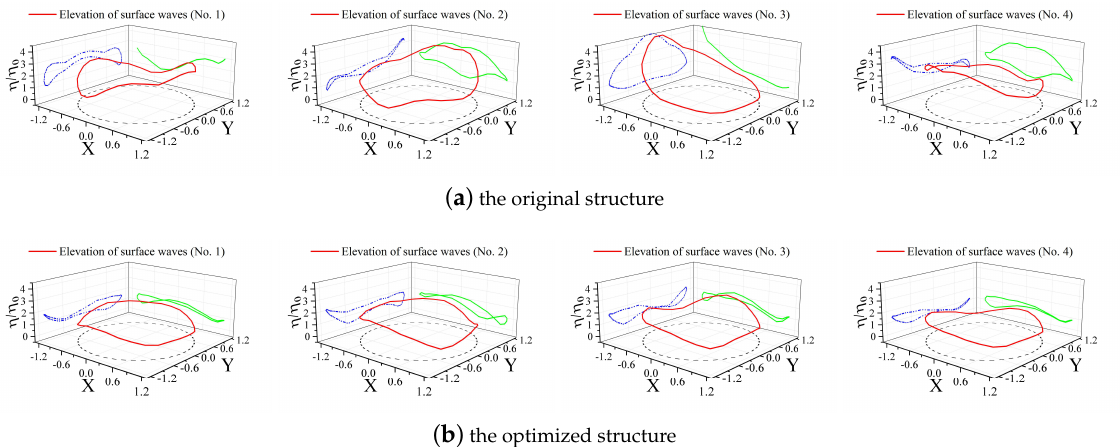
Figure 20. The free-surface and scattered-wave elevations of the four-column structure at k 0 a = 1.68 against three different wave-approach